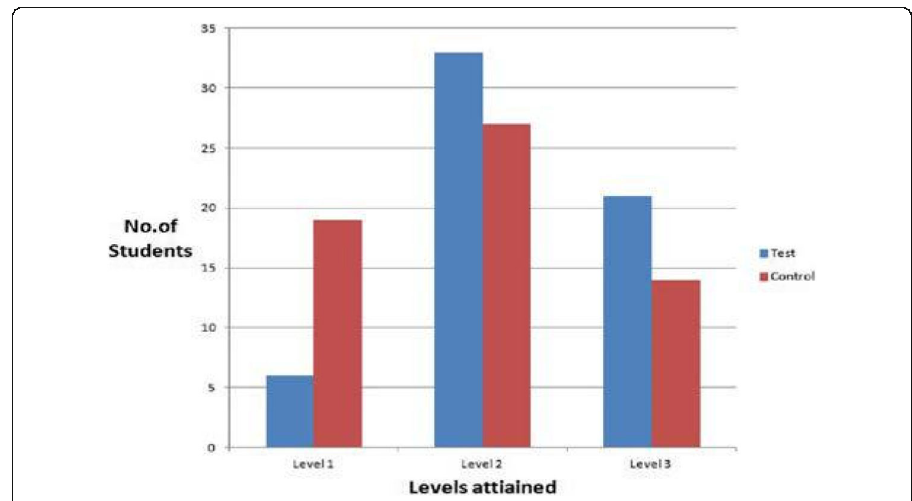
Fig. 5 Maximum Game Levels Attained by Test and Control